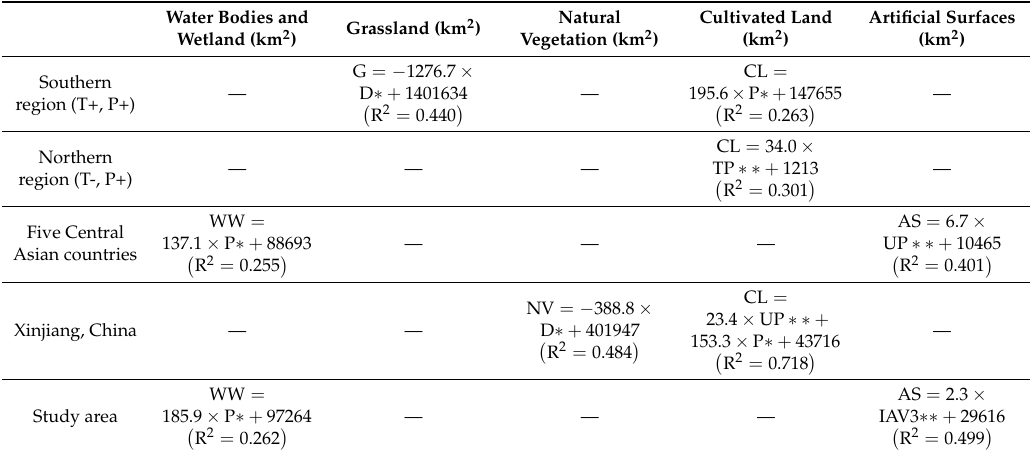
Table 3. Relationships between land cover and driving factors in different zones. Water Bodies and Natural Grassland (km 2 ) Vegetation (km 2 Wetland (km 2 )